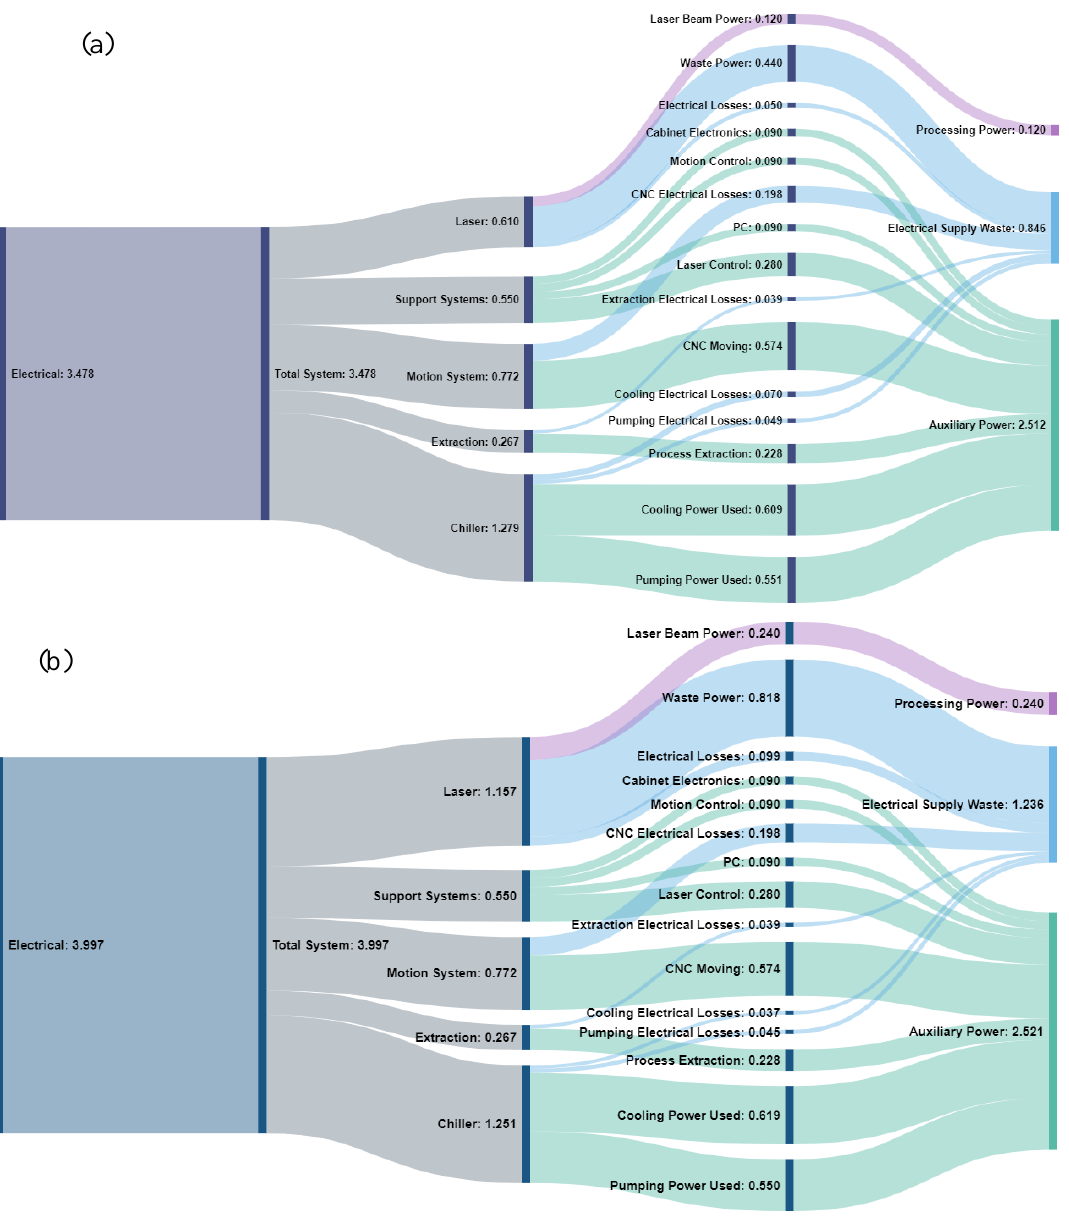
Figure 6. Laser welding power flows (kVA), ( a ) with the laser beam power at 120 W and ( b ) with the laser beam power at 240 W.